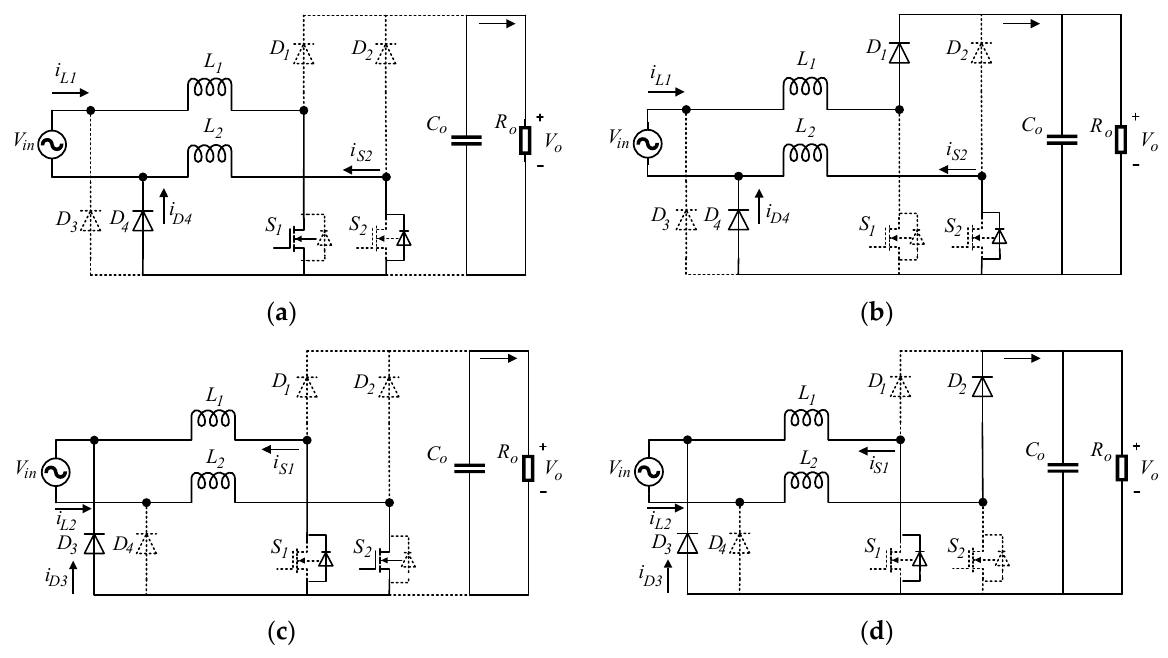
Figure 2. Working state of dual - boostbridgeless PFC converter: ( a ) V in > 0, S1 opens; ( b ) V in > 0, S1 shuts down; ( c ) V in < 0, S2 opens; ( d ) V in < 0, S2 shuts down.